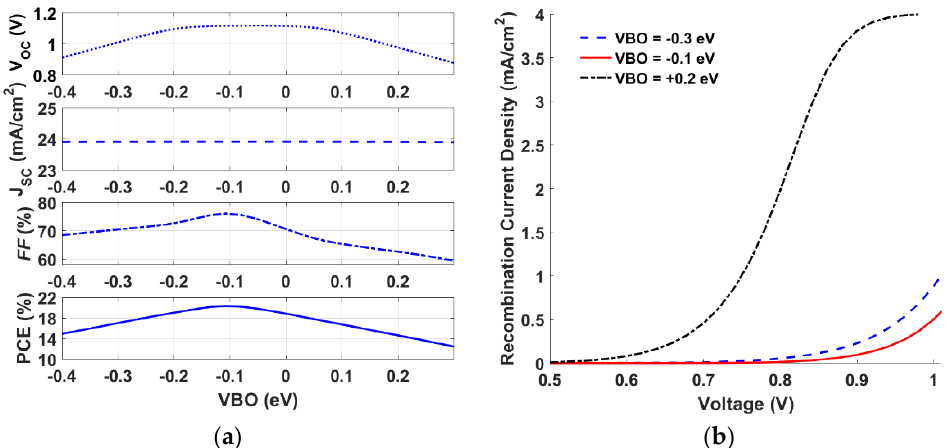
Figure 4. Impact of VBO: ( a ) Variation of PV performance factors versus VBO, and ( b ) Interface recombination current for different values of VBO.